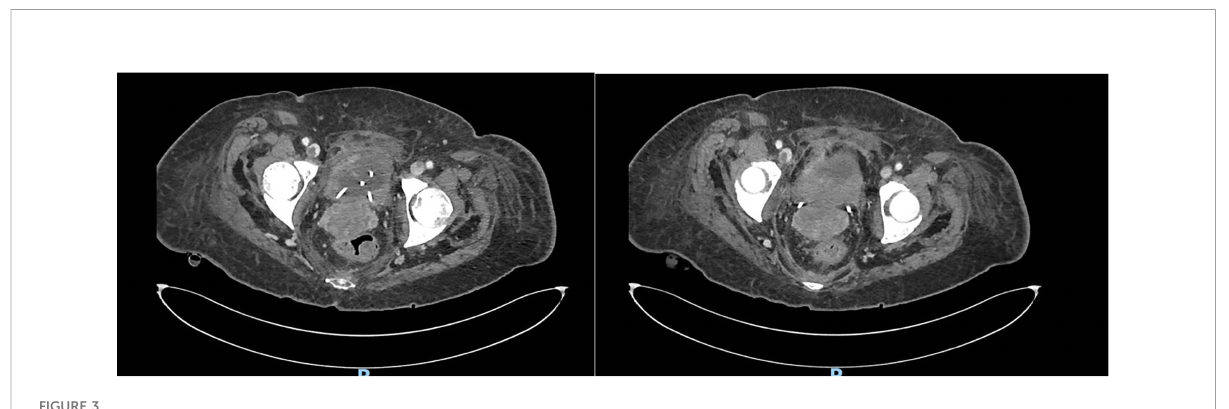
FIGURE 3 Bladder wall thickening documented on CT